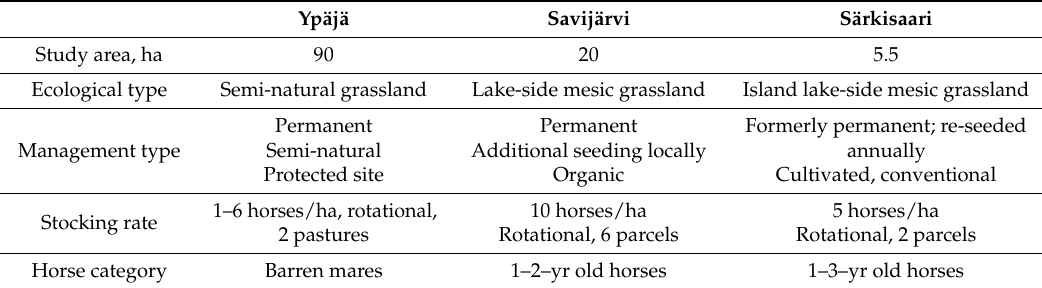
Table 1. The main ecological and management-related characteristics of the study